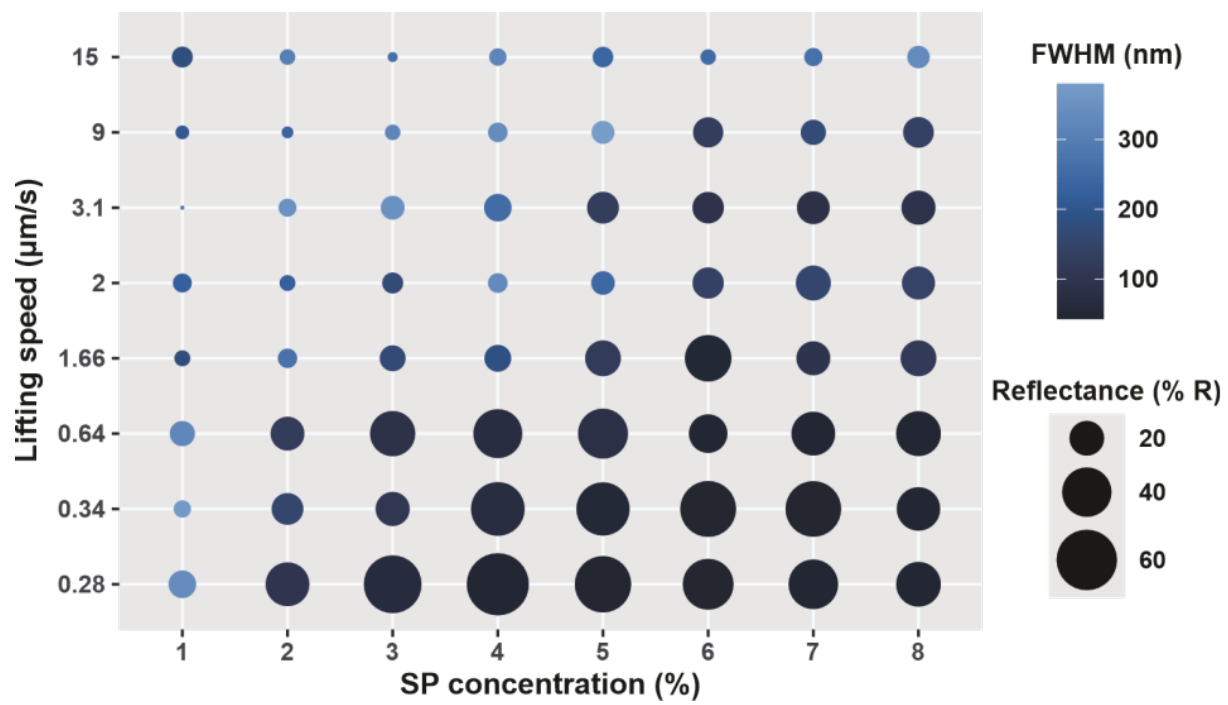
Figure 5. FWHM and peak reflectance intensity (R%) of C-PC, as a function of lifting speed and particle concentration.